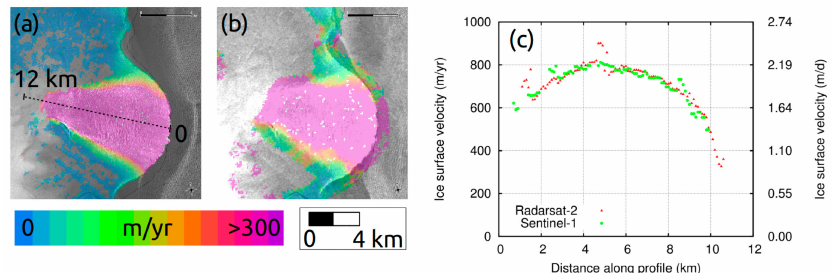
Figure 16. Ice velocity maps on Stonebreen (Svalbard) from ( a ) Radarsat-2 WUF data of 04/28-02-2016 and ( b ) Sentinel-1 data of 09/21-02-1016 and ( c ) inter-comparison along the centre flow line plotted in ( a ).